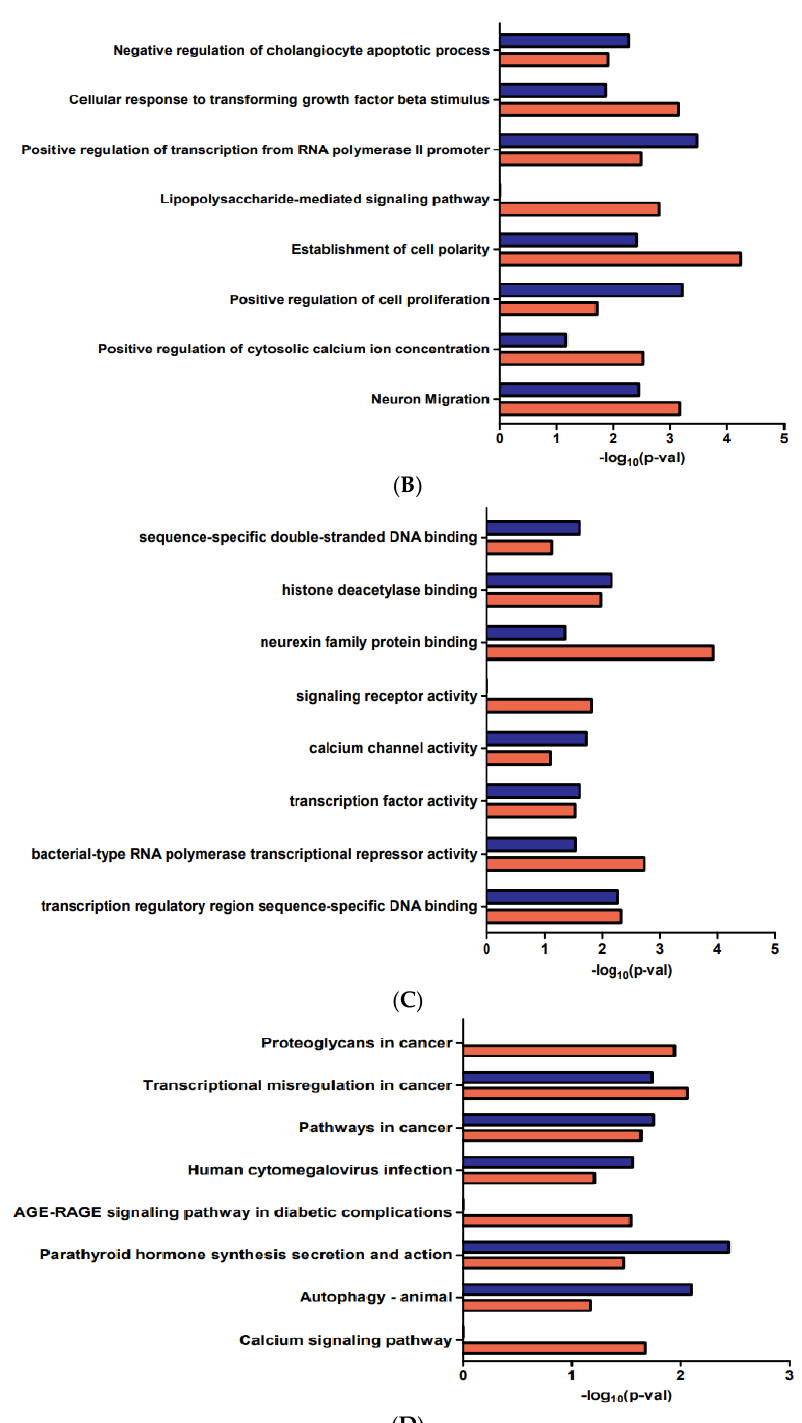
Figure 2. GO and KEGG enrichment analysis of DEGs. ( A ) CC functional classification terms of genes. ( B ) BP functional classification terms of genes. ( C ) MF functional classification terms of genes. ( D ) KEGG analysis of genes. BP, biological process; CC, cellular component; DEGs, differentially expressed genes; GO, Gene Ontology; KEGG, Kyoto Encyclopedia of Genes and Genomes; MF, molecular function.